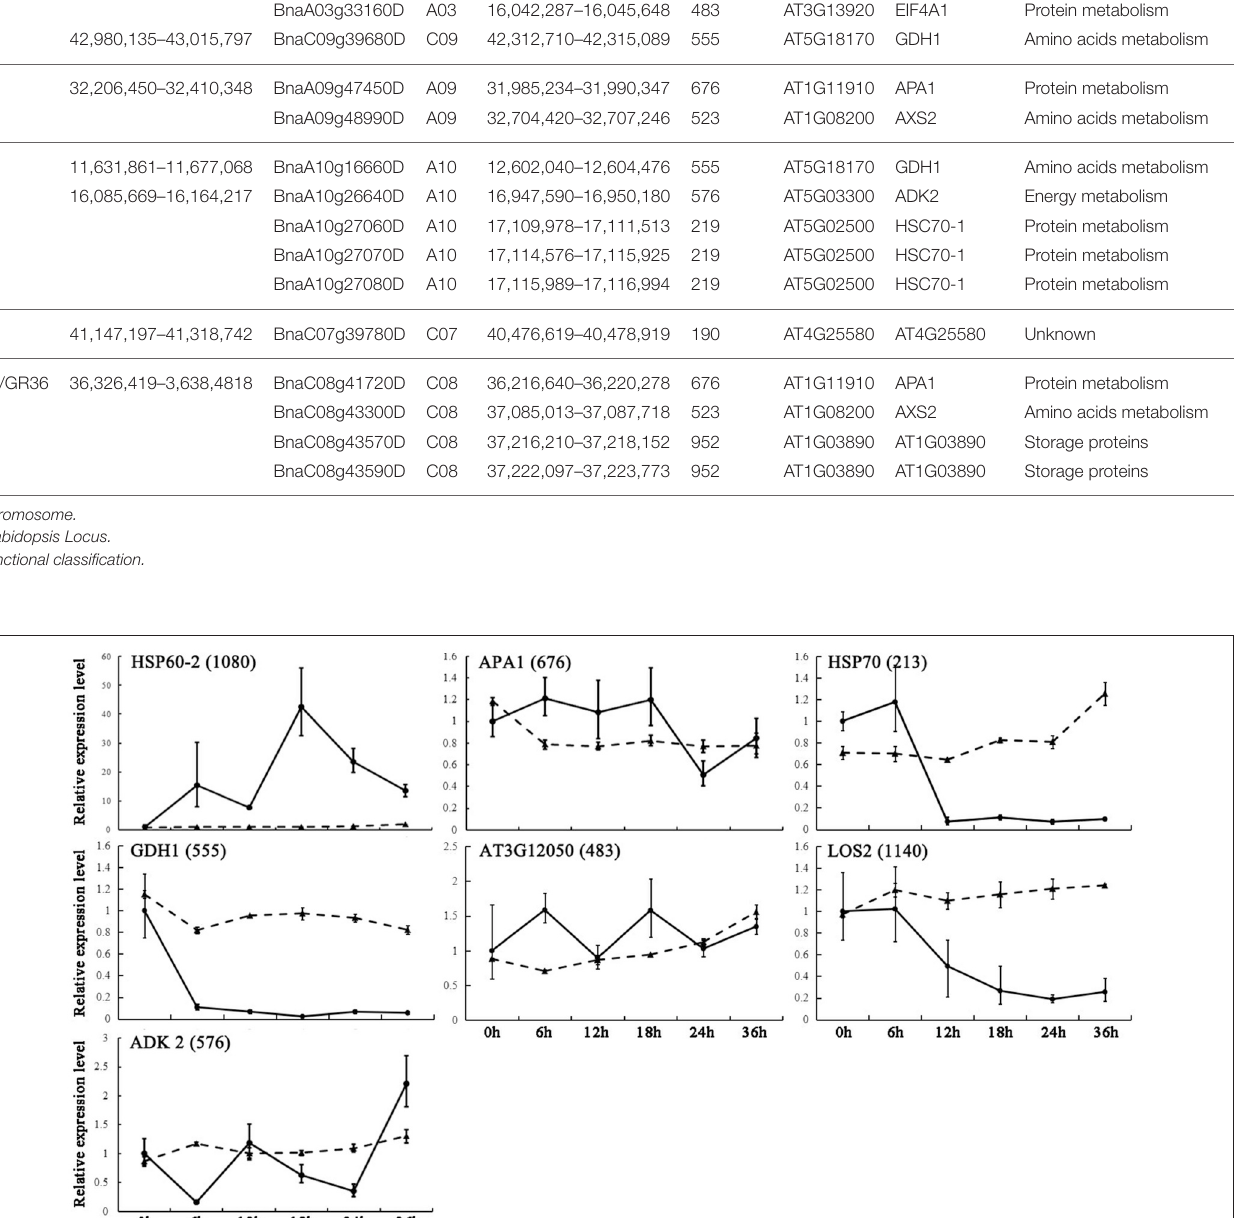
Frontiers in Plant Science |